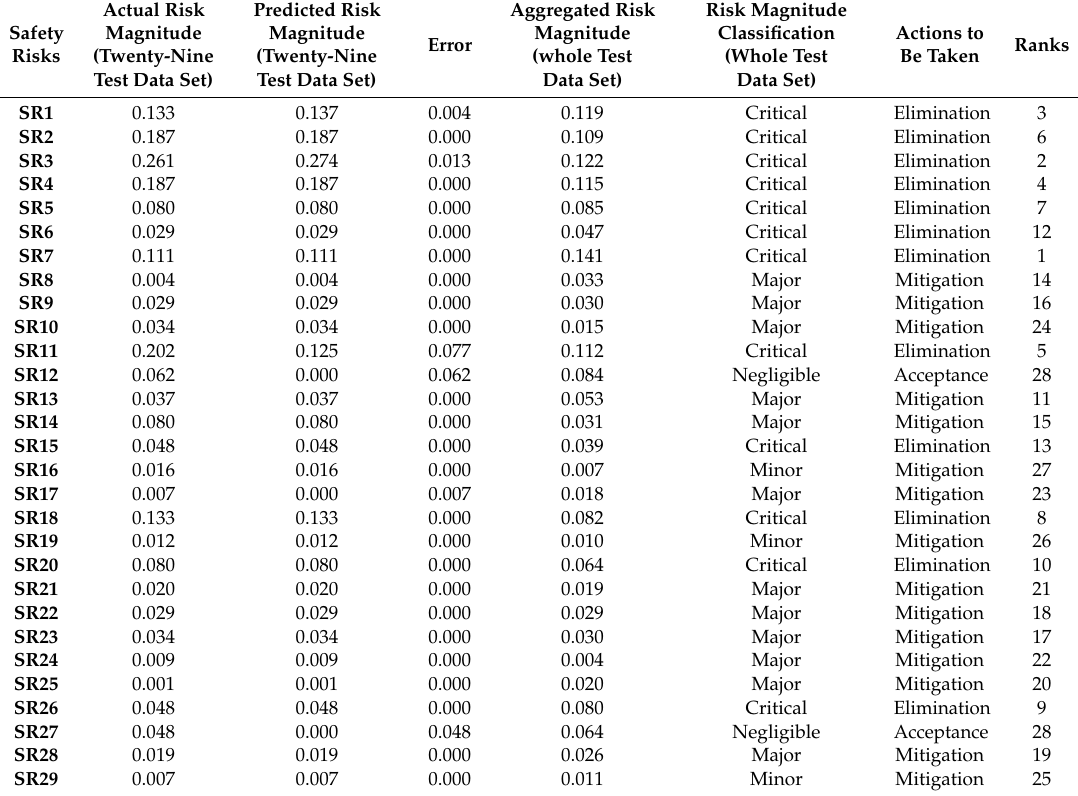
Table 10. Risk magnitudes and classifications of safety risks related to testing data sets and aggregation of all data sets.